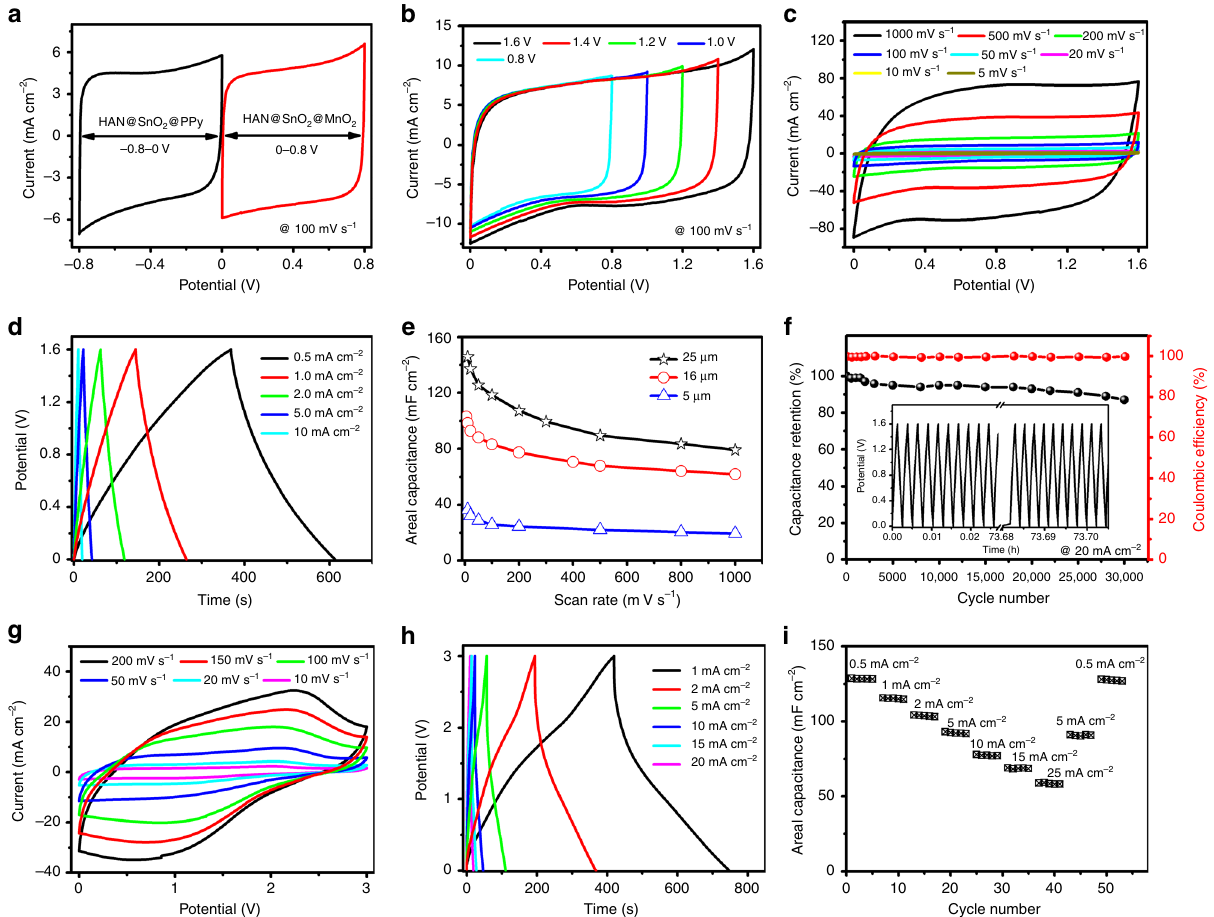
Fig. 5 Electrochemical performance of HAN@SnO 2 @MnO 2 //HAN@SnO 2 @PPy asymmetric MSCs. a Typical CV curves of HAN@SnO 2 @MnO 2 and HAN@SnO 2 @PPy based symmetric MSCs, respectively, with 1.0 M Na 2 SO 4 electrolyte. b CV curves within different potential ranges. c CV curves at different scan rates. d GCD pro fi les at different current densities. e Device areal capacitance as a function of current densities. f Cycling stability test at a scan rate of 20 mA cm − 2 . g CV curves at different scan rates, h GCD pro fi les at different current densities, and i rate performance of asymmetric MSCs with EMIM-TFSI electrolyte, respectively.